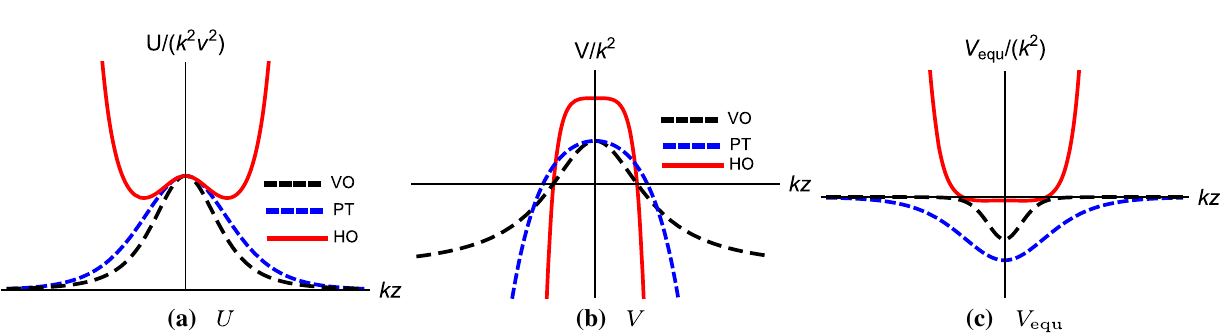
Fig. 2 The shapes of the mimetic field φ( z ) , and the warp factors e A for all cases